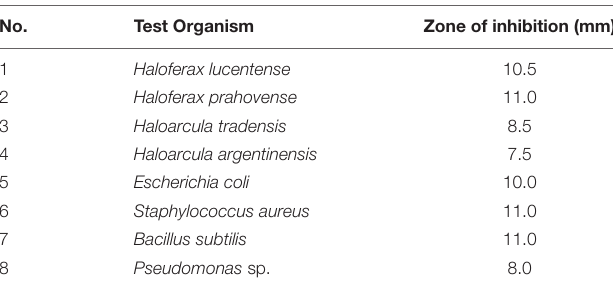
TABLE 2 | Inhibitory effect of SNPs synthesized using C. tamala extract against haloarchaea and